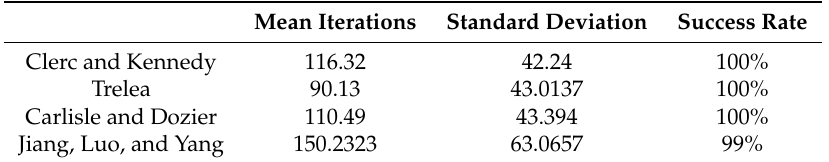
Table 5. PSO performance for n = 50.